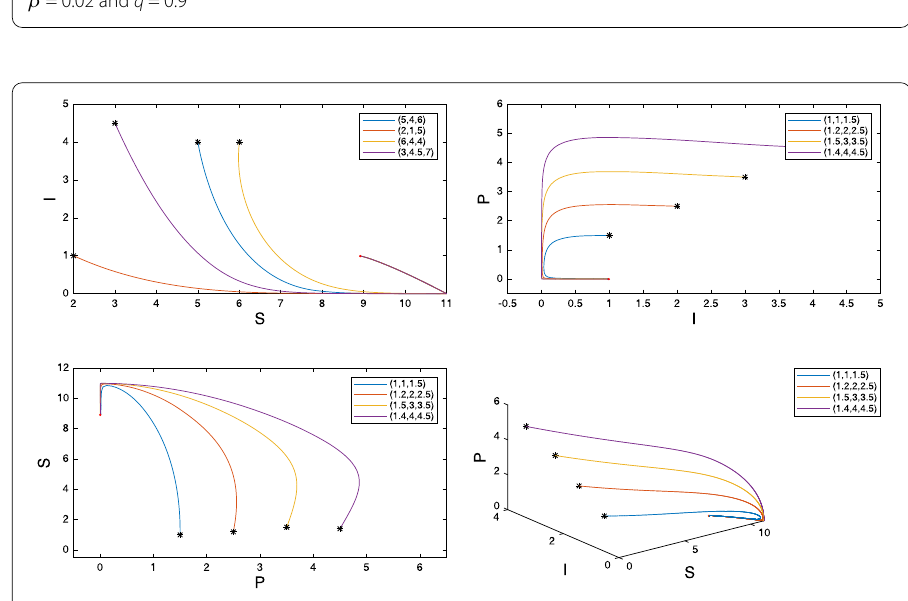
Figure 8 Global asymptotic stability of the predator-extinction equilibrium point E 2 with different initial values when β = 0.24 and q =